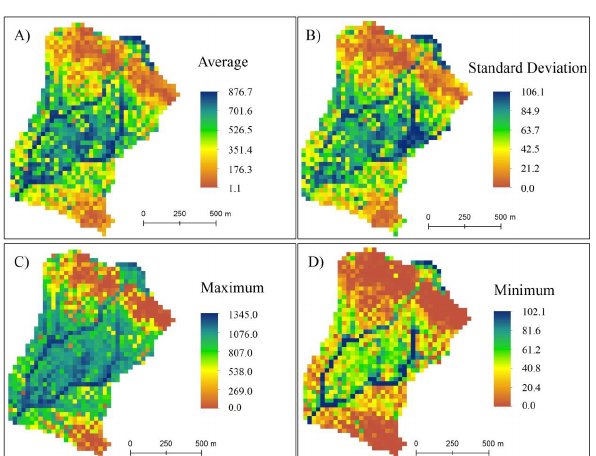
182.8 Figure 9. Simulated average pasture production and precipitation at Site 2 , A) at the annual timescale for Figure 10. Spatial distribution of simulated pasture production ( kg DM ha -1 ): A) Average; B) Standard deviation; C) Maximum; D) Minimum.